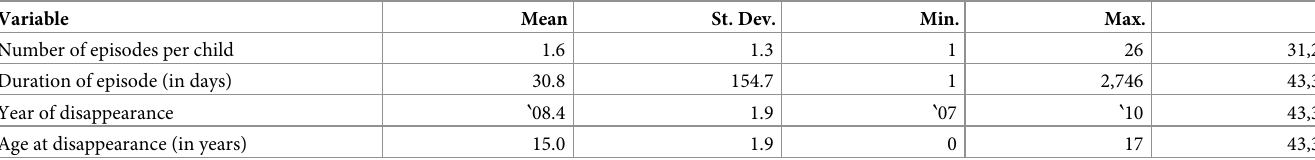
Table 1. Descriptive statistics for cardinal variables.